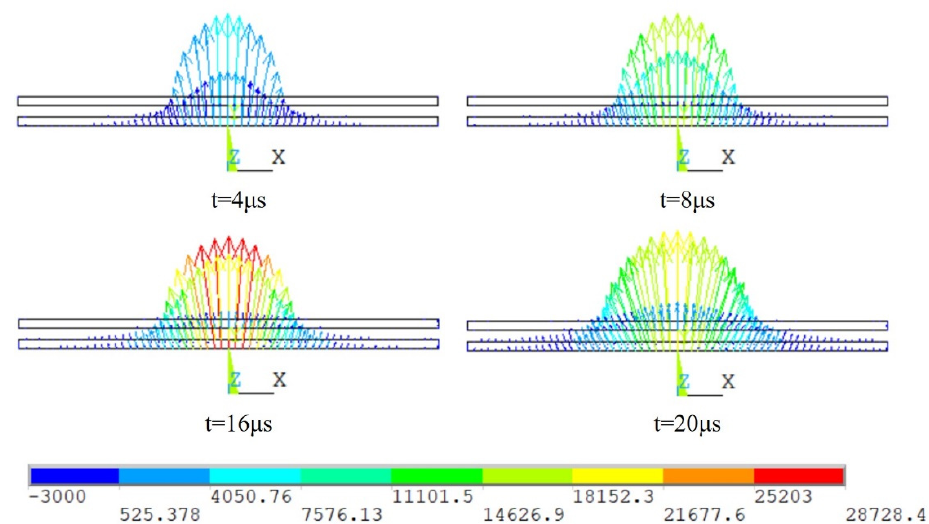
Figure 14. Distribution of electromagnetic force at typical time.